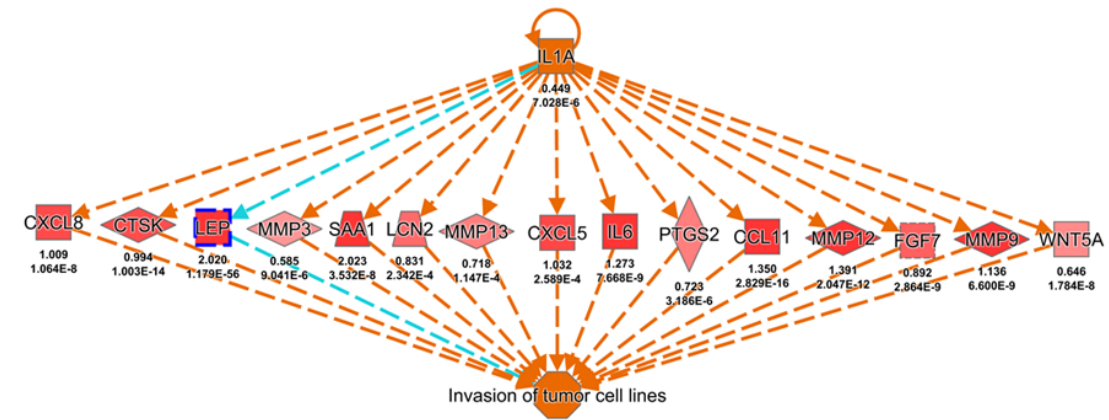
Figure 2. Transcriptomic alteration-based identification of potential diseases and functions modulated upon leptin upreg- ulation. A total of 20,530 gene expression data from each ccRCC patient were retrieved from The Cancer Genome Atlas TCGA. The differential gene signatures were obtained after comparing each gene in the high leptin group to each gene in the low leptin group. Gene targets were further filtered by the log2-transformed 1.5-fold change and p value (<0.05) for ingenuity pathway analysis (IPA) (938 gene targets). The putative regulatory network of the top diseases and functions is presented. E: e notation indicated “× 10 n ” of a value m × 10 n .